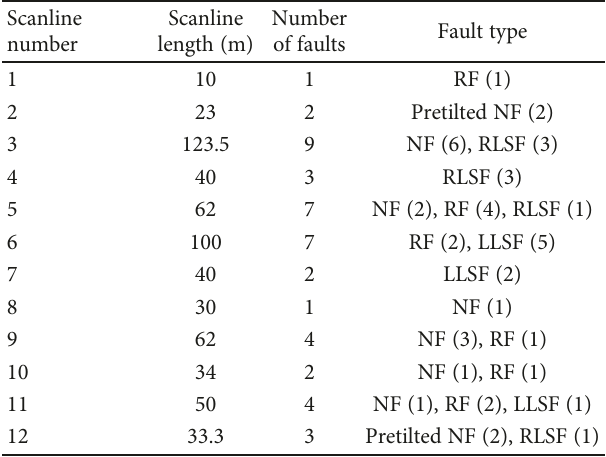
Table 1: A list of the scanlines and number of di ff erent types of faults in each scanline measured in Vallone di Santo Spirito. The following abbreviations were used: RF: reverse fault; NF: normal fault; RLSF: right-lateral strike-slip fault; LLSF: left-lateral strike-slip